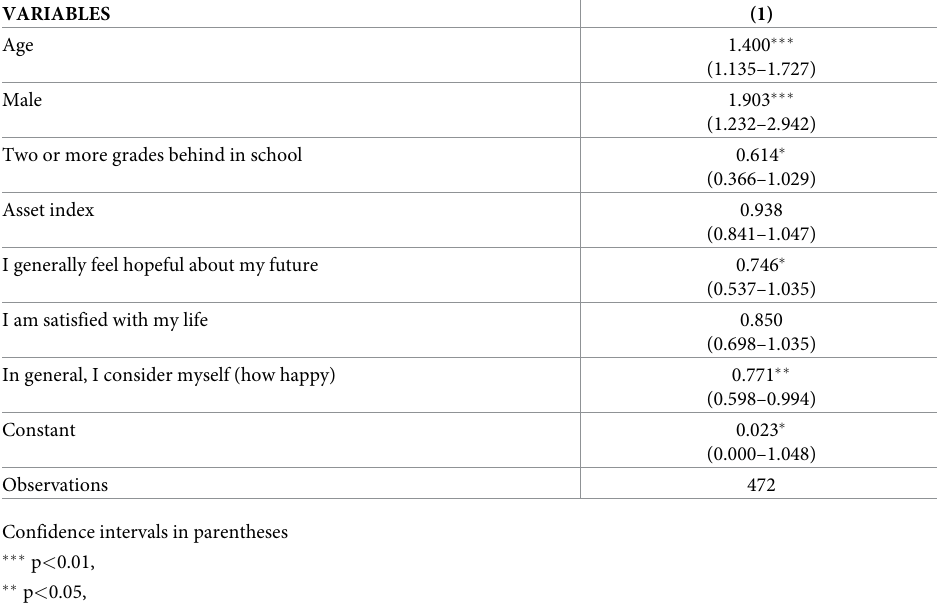
Table 9. Alcohol use regression, including assets, hope, happiness and life